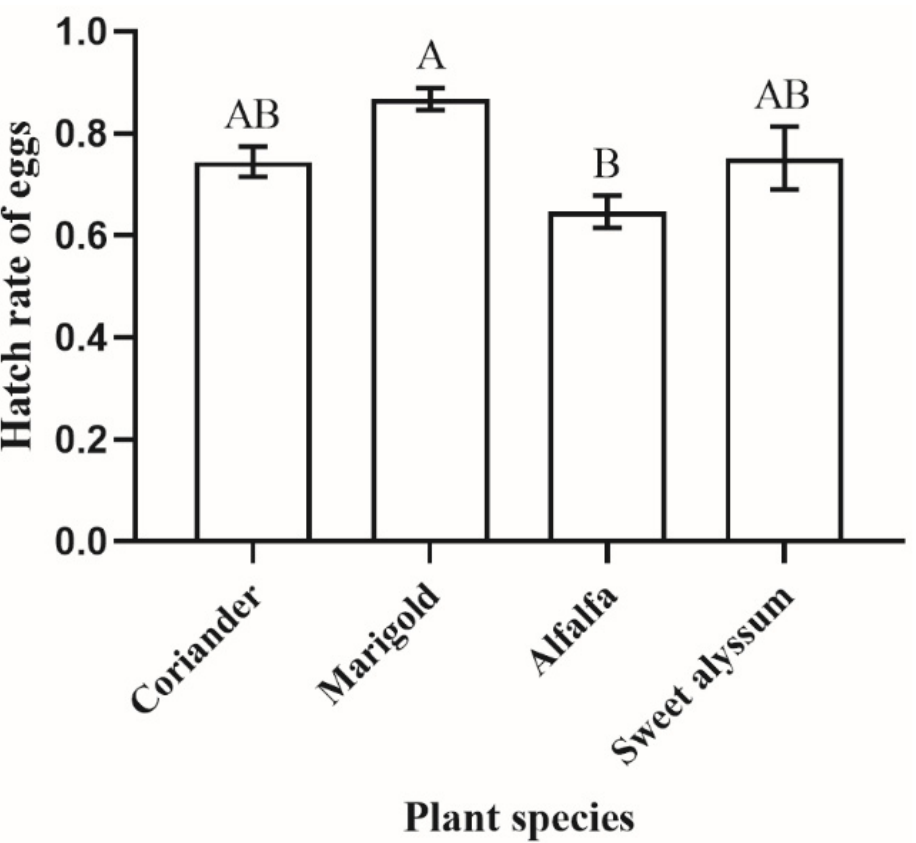
Figure 3. The hatchability of Orius sauteri eggs on different plant species ( n = 6; α = 0.05; Kruskal– Wallis nonparametric comparison). Values are mean ± SE. Means indicated by the same letter are not significantly different.